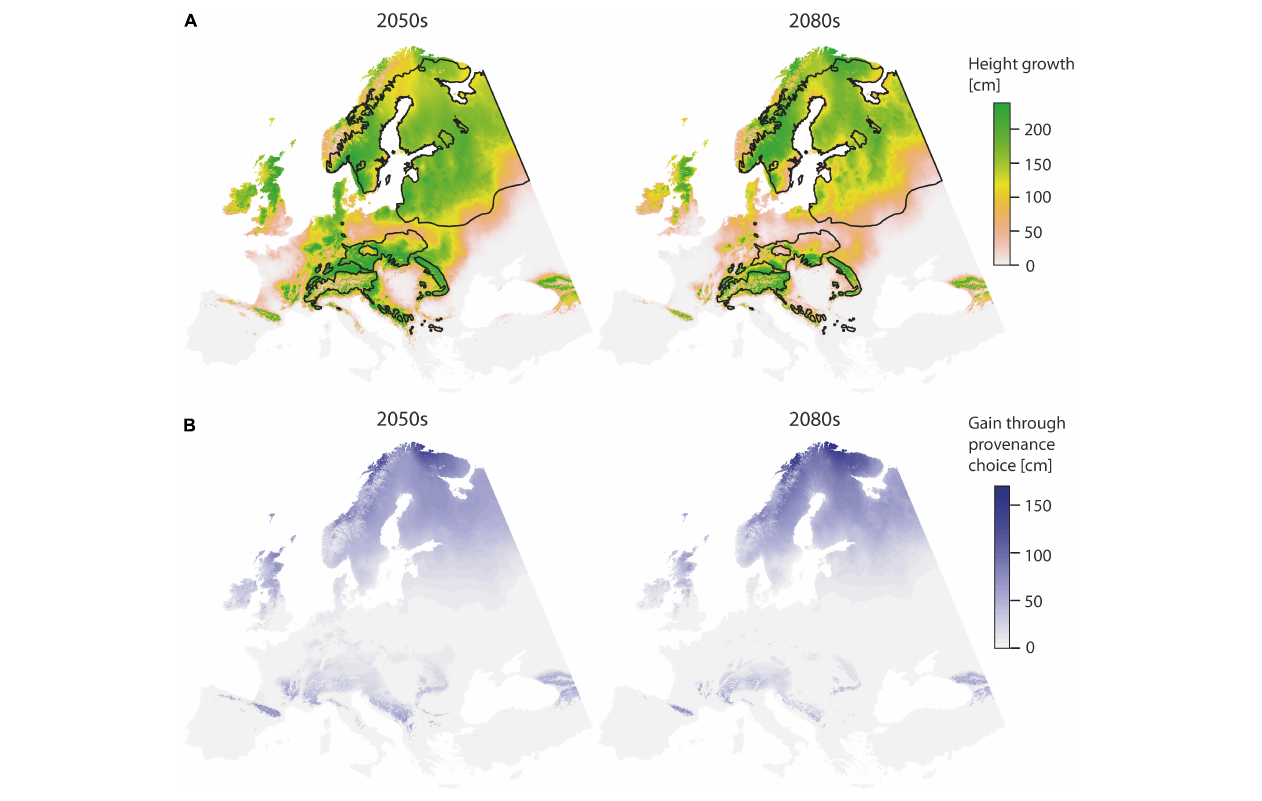
FIGURE 4 | Spatial prediction of the TraitSDM for height age 11 using “optimal” provenance, as identified by solving the first order partial derivatives for climatic and geographic variables for provenance in the model (TD_p and Lat_p), for the predicted scenarios 2050s and 2080s (A) . The potential of height gain through model-based provenance choice is indicated (B) . Black lines indicate the natural